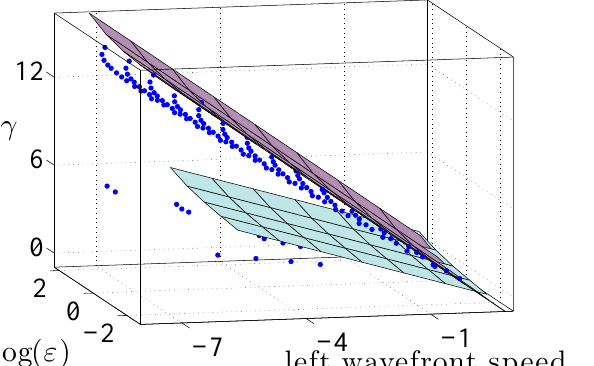
(cid:112) (cid:112) (1 + p + (1 − p ) ε 1 − µ 2 . (cid:112) (cid:112) 1 − p + (1 + p ) ε 1 − µ 2 . The similar dark √ (cid:112) 2 ε 1 − µ 2 ; the mid-toned, shortened surface is the low √ 2 . The points are data read from numerical solutions